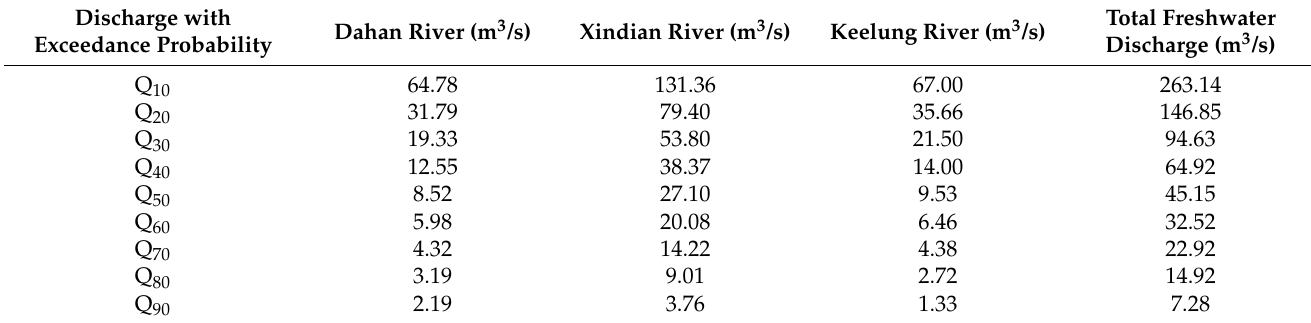
Table 1. Freshwater discharge inputs at the upstream reaches of three major